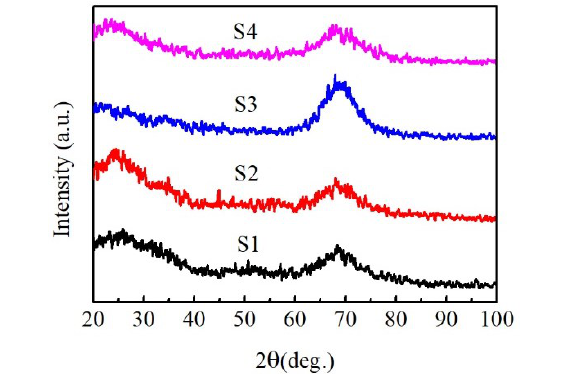
Fig. 3. XRD plots showing the amorphous structure of films.